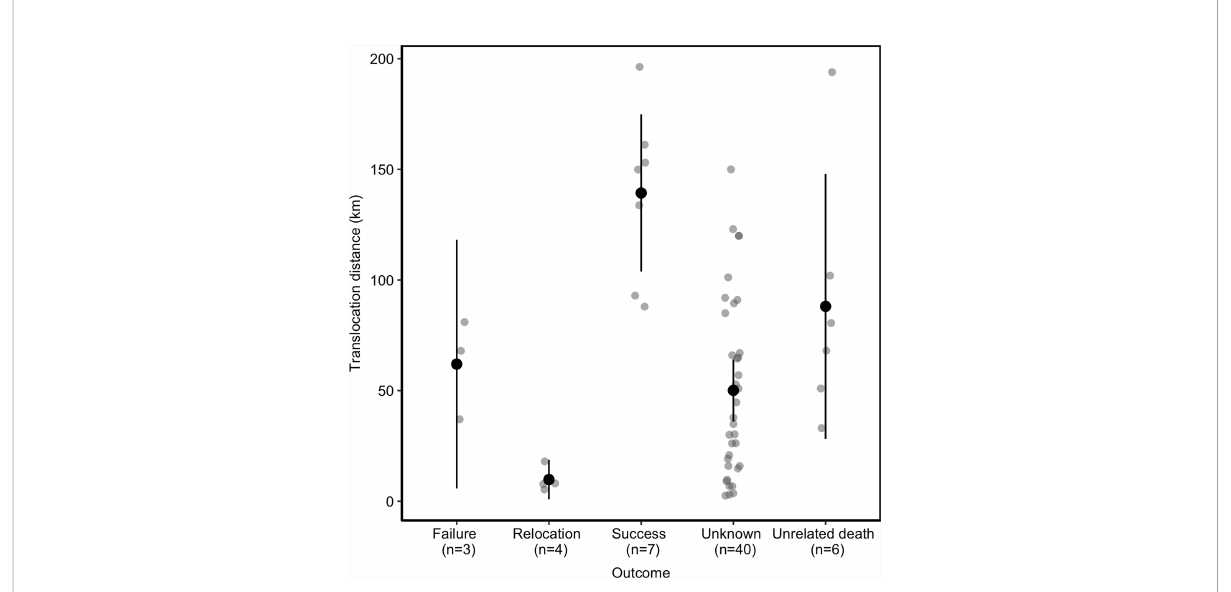
FIGURE 2 Outcome of translocated leopards in relation to the distance moved, with the average distance and 95% con fi dence